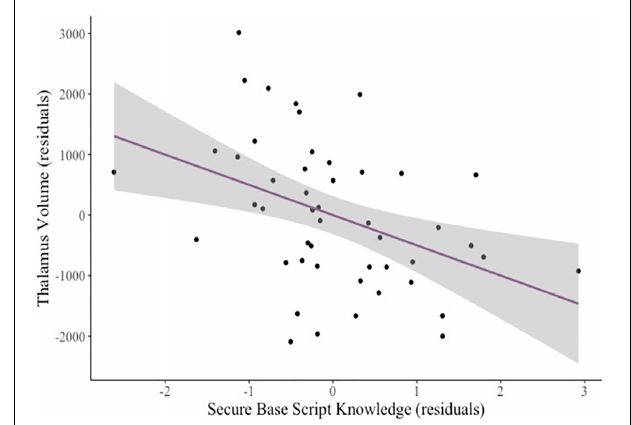
FIGURE 1 | Added variable plot displaying the partial correlation between mothers’ secure base script knowledge and children’s left amygdala volume controlling for covariates (sex and age). The shaded region reflects the 95% confidence interval around the regression line.